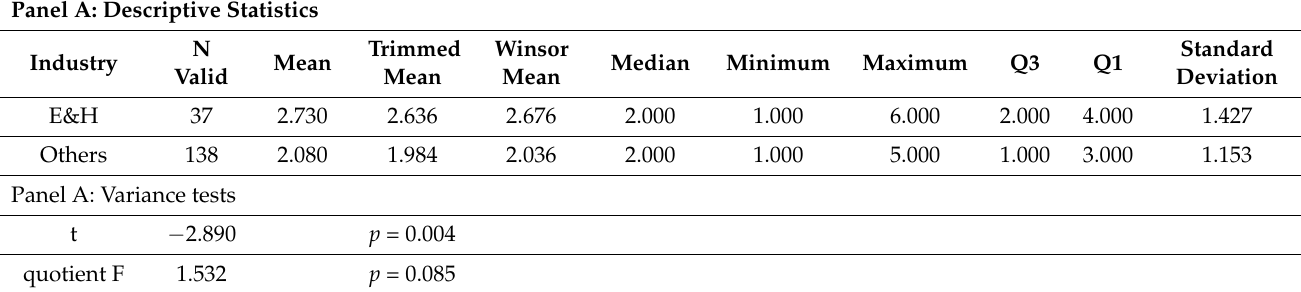
Table 5. Number of different types of responsibility centres in the surveyed